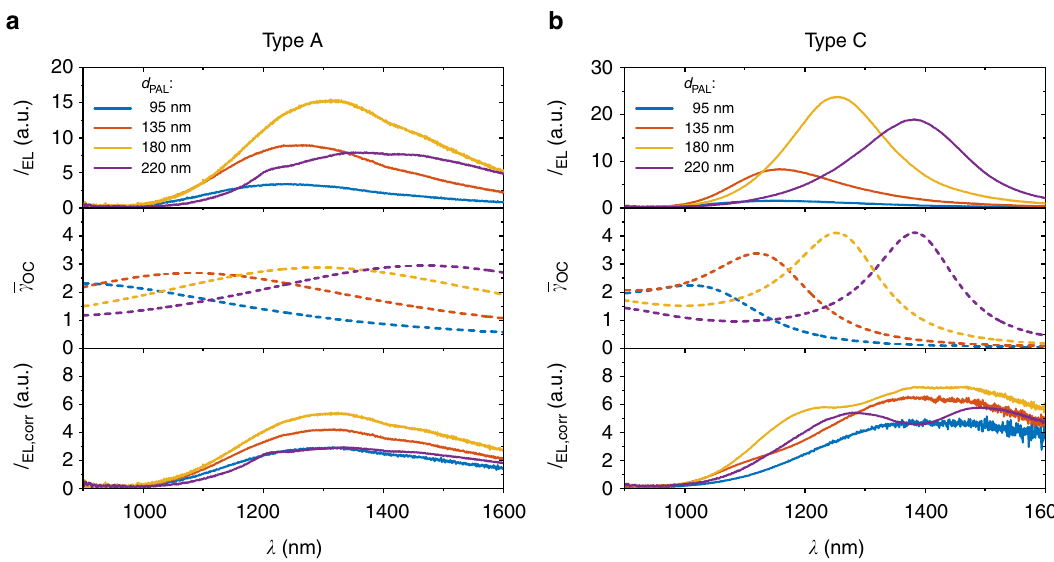
Fig. 3 EL spectra I EL ( λ ) of P3HT:PC 61 BM solar cells for different absorber thicknesses d PAL . For ITO-free devices type A in a and ITO-based devices type C in b , the calculated radiant out-coupling factors (cid:1) γ I ¼ I (cid:3) (cid:1) γ (cid:2) 1 EL ; corr EL OC